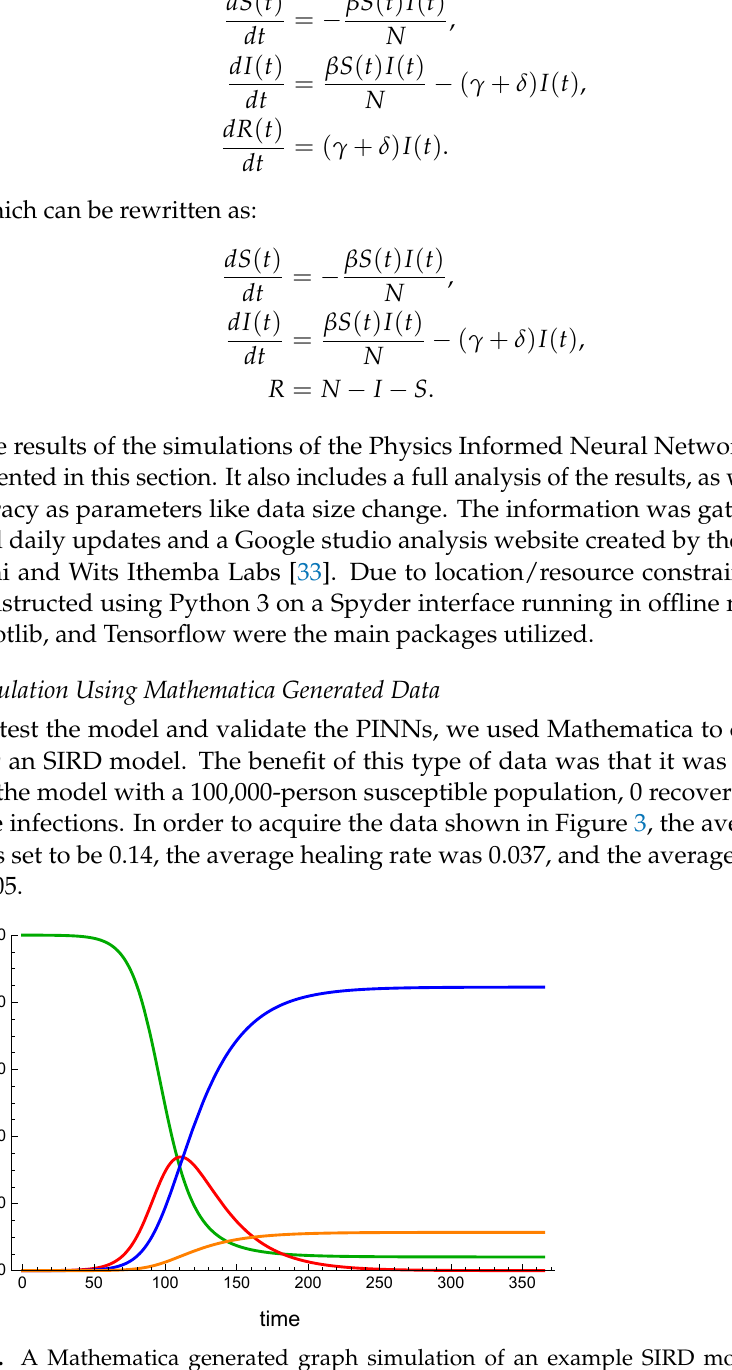
Figure 3. A Mathematica generated graph simulation of an example SIRD model. The green represents Susceptible population, blue represents the recoveries, red is the active infected population and orange is the deceased